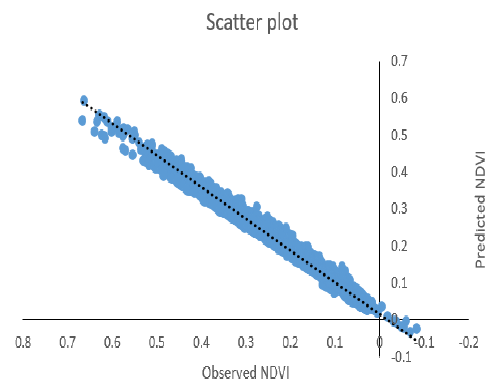
Figure 5. Scatter plots for Observed NDVI and predicted NDVI in July